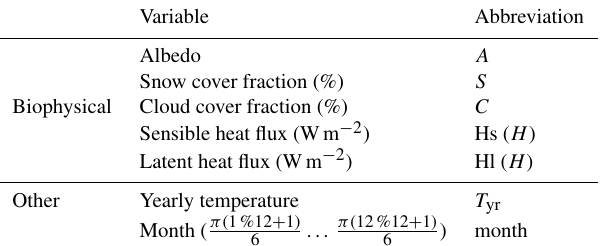
Table 1. List of biophysical variables used in training the gradient boosting